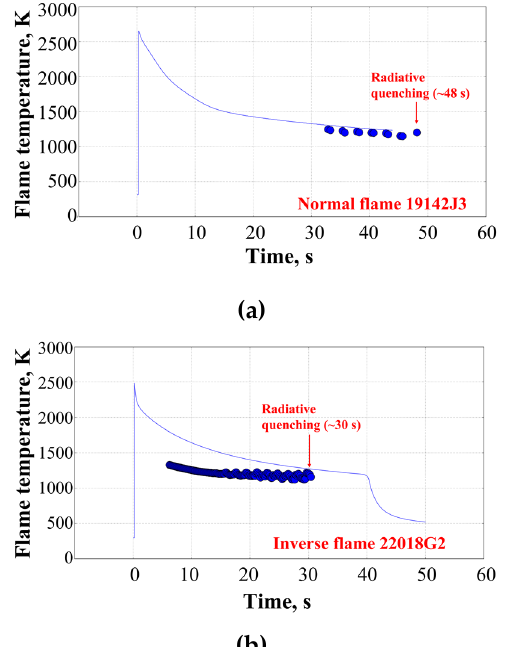
Figure 3. Examples of the time histories of the flame radius: ( a ) normal flame; ( b ) inverse flame. Symbols correspond to the experiment, and the curves correspond to the calculation.